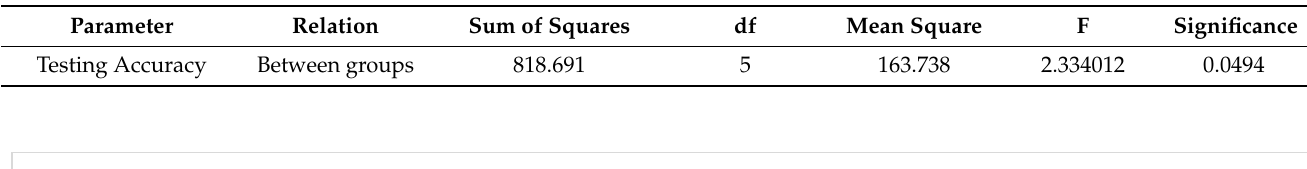
FFNN Classification Accuracy of QRS with Opposition-Based PSO Ranked Inertia Weight